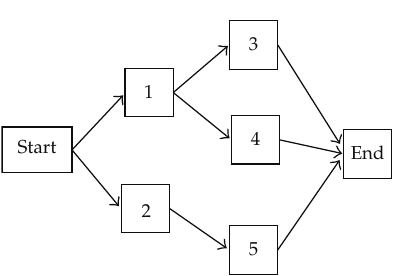
Figure 1: An example of a studied task scheduling